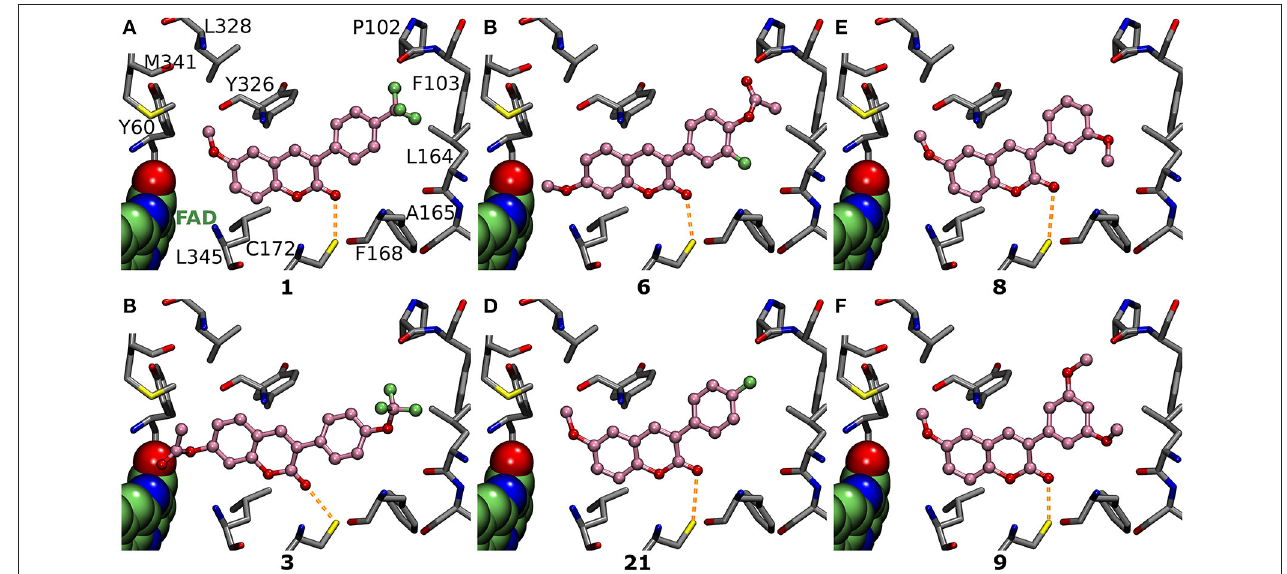
FIGURE 5 | The vital role of R4-R7 substituents of the 3-phenyl ring for the inhibition. Focusing on the 3-phenyl ring, the derivatives (ball-and-stick models with pink backbone) elicit strong MAO-B inhibition via (A) R6-trifluoromethyl ( 1 ; Figure 2 ; IC 50 of 56nM; Table 1 ), (B) R6-trifluoromethoxy ( 3 ; Figure 2 ; IC 50 of 141nM; Table 1 ), (C) R6-acetoxy and R7-fluorine ( 6 ; Figure 2 ; IC 50 of 189nM; Table 1 ), (D) R6-fluorine ( 21 ; Figure 2 ; IC 50 of 433nM; Table 1 ), (E) R7-methoxy ( 8 ; Figure 2 ; IC 50 of 231nM; Table 1 ), and (F) R5- and R7-methoxy ( 9 ; Figure 2 ; IC 50 of 255nM; Table 1 ) groups. See Figure 1 for further